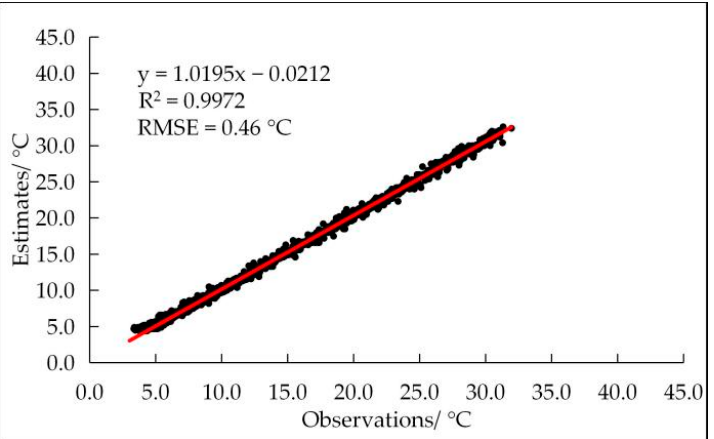
Figure 7. Linear fitting analysis chart of estimated and observed values. The observed data are the temperature data of M1 and M4.